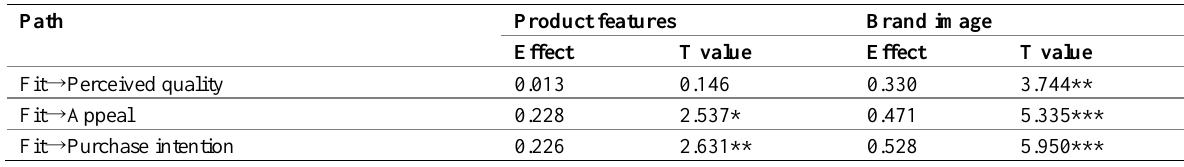
Table 12: The results of hypothesis testing for moderating effect